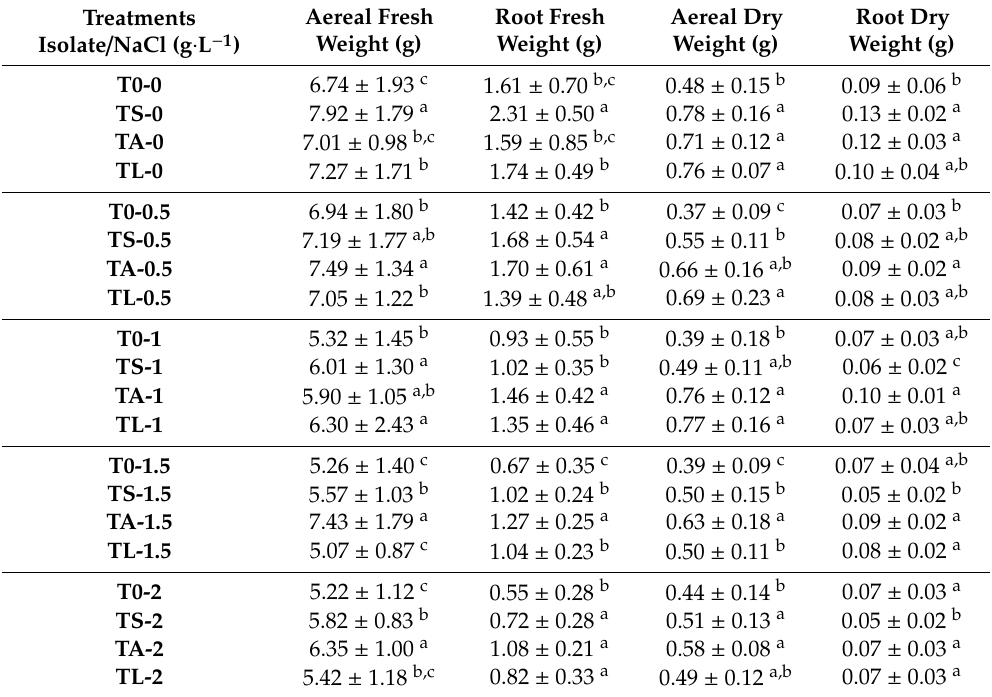
Table 1. Morphological parameters of melon plants treated with di ff erent doses of NaCl and Trichoderma